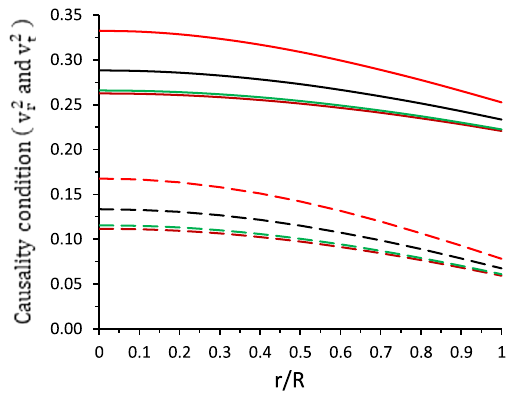
Fig. 4 The trend of the anisotropic factor ( Δ ) versus radial coordinate r / R . The description and numerical values for the free parameters are same as used Fig. 3